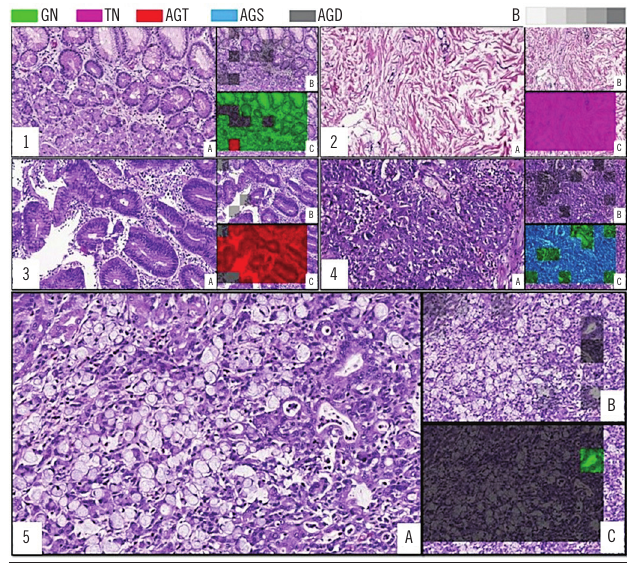
figura 5 – As imagens marcadas de 1 a 5 ilustram os resultados para as cinco diferentes classes. As imagens marcadas pela letra A são as amostras sem classificação; as marcadas com a letra B, as amostras e seus respectivos graus de certeza (conforme a gradação B cinza no código de cores: quanto mais escuro maior a incerteza); e as marcadas com a letra C, as classificações geradas pelo algoritmo, conforme o código de cores na legenda GN: epitélio gástrico normal; TN: tecidos normais não epiteliais; AGT: epitélio gástrico neoplásico/adenocarcinoma gástrico tubular; AGS: adenocarcinoma gástrico de tipo sólido; AGD: adenocarcinoma gástrico de tipo